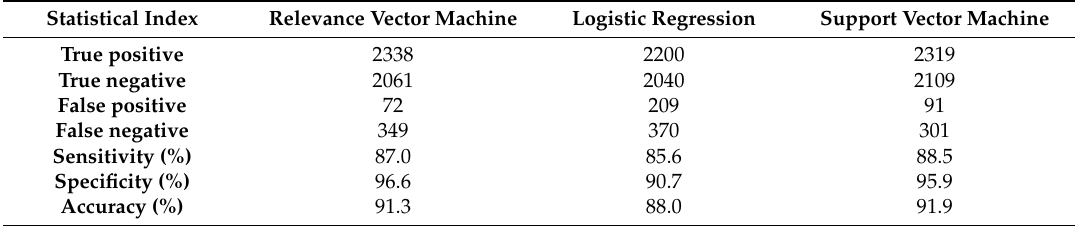
Figure 9. Area under the ROC curve (AUC) of the three models using the validation dataset. Table 3. Model performance using the training dataset.